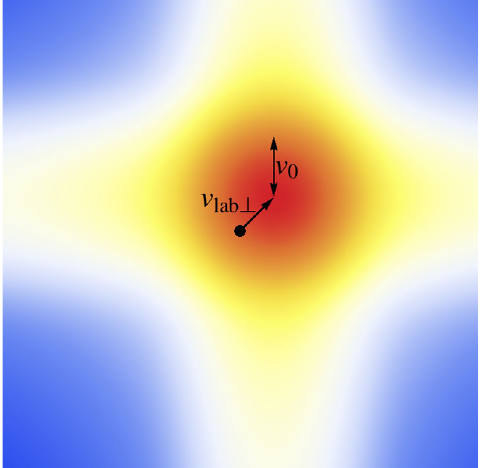
FIG. 2. Density plot of the logarithmic intensity as measured by a horizontal screen placed far above a thin slab in the xy plane, zoomed in on the directions close to the normal vector defined by θ ¼ 0 , which pierces the screen at the location of the dot shown. The angular radius of the main emission region is the expected DM velocity dispersion measure v 0 ≈ 0 . 78 × 10 − 4 rad. The vector shows the angular offset of the cone ’ s center to the normal; its magnitude and direction are given by the projection v of the average DM velocity v onto the xy plane in the lab lab ⊥ lab